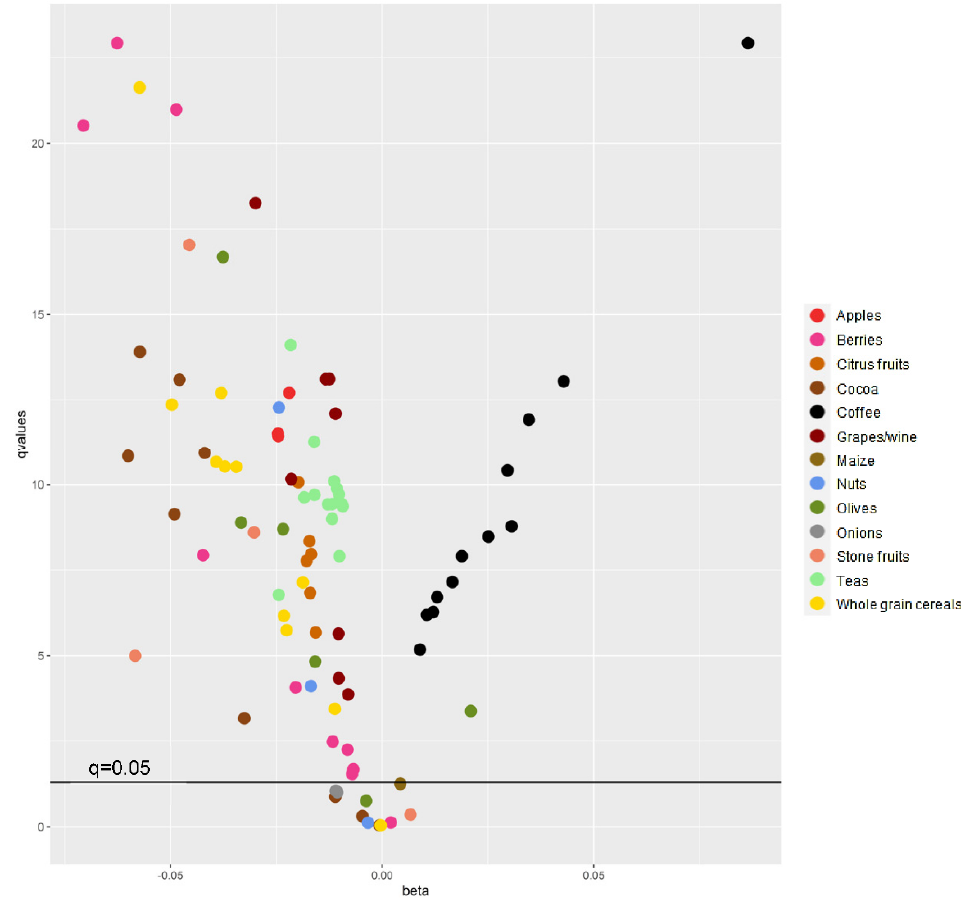
Figure 1. False discovery rate (FDR) q values and beta values (kg/5 year) of associations between 91 polyphenols and 5-year body weight change and their main food sources. Beta values correspond to a doubling in intake. q values (adjusted p value for FDR) are shown as -log10-transformed values to improve visualization. 1 Multilevel linear mixed model with random effects on the intercept according to EPIC centre adjusted for age, sex, body mass index (3-knot restricted cubic spline), follow-up time in years (3-knot restricted cubic spline), alcohol intake (g/d), education level, physical activity level, smoking status at follow-up, menopausal status, total energy intake (kcal/day), plausibility of dietary energy reporting, vitamin C intake (mg/d), and fibre intake (g/d) (Model